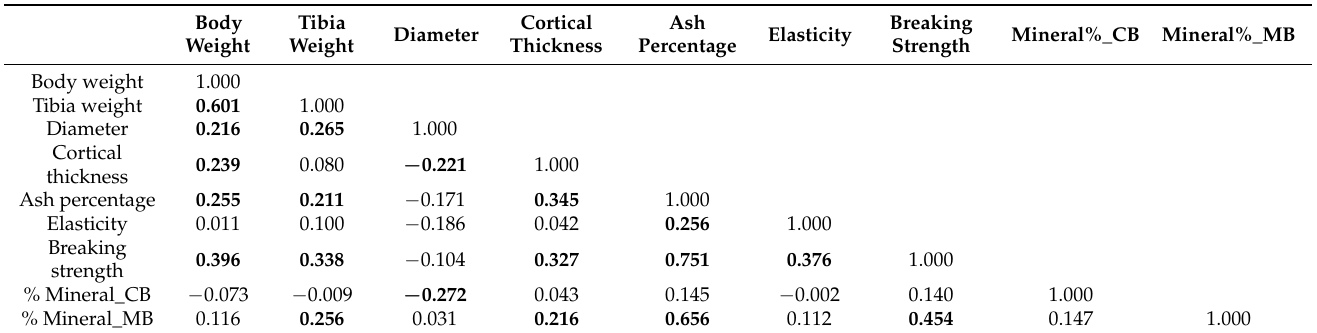
Table 4. Pearson’s correlation between some tibiae bone properties.